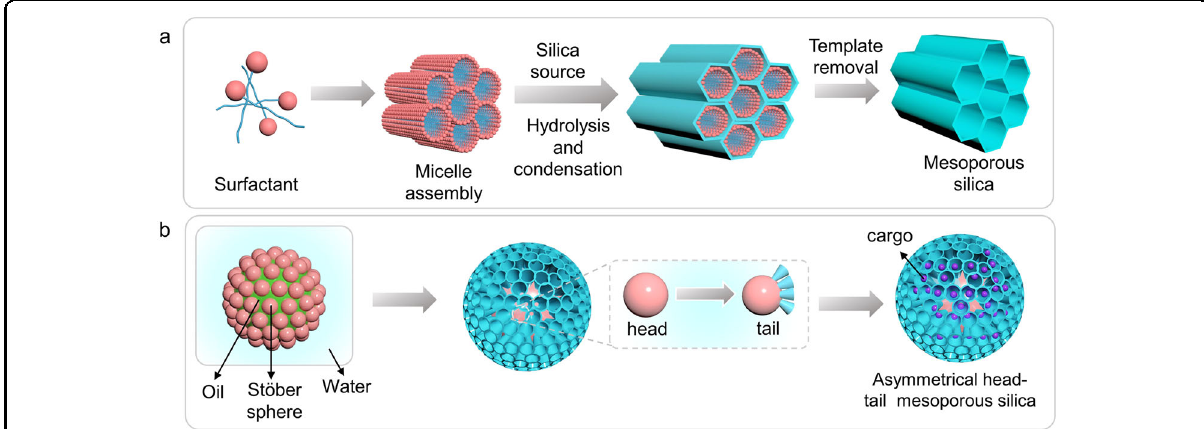
Fig. 5 Schematic illustration of the synthetic route for mesoporous silica nanoparticles (MSNs). a Typical method for the synthesis of MSNs and ( b ) Stöber